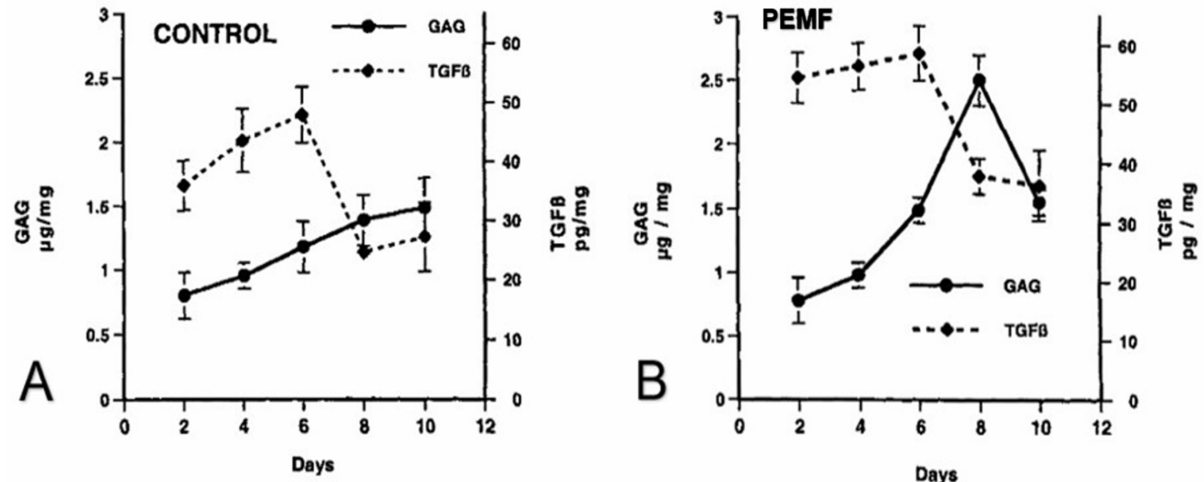
Figure 11. Coordinated chondrogenesis and TGF- β . ( A ) In control (unexposed) ossicles, TGF- β protein synthesis is coincident with glycosaminoglycans (GAGs) preceding and during chondro- genesis and decreases with the onset of calcification. ( B ) In PEMF-exposed ossicles, an increase in glycosaminoglycans (GAGs) is seen with chondrogenesis. TGF- β protein is markedly increased and then decreases with the onset of matrix calcification. Adapted with permission from Ref. [10]. 2002, Journal of Orthopaedic Research